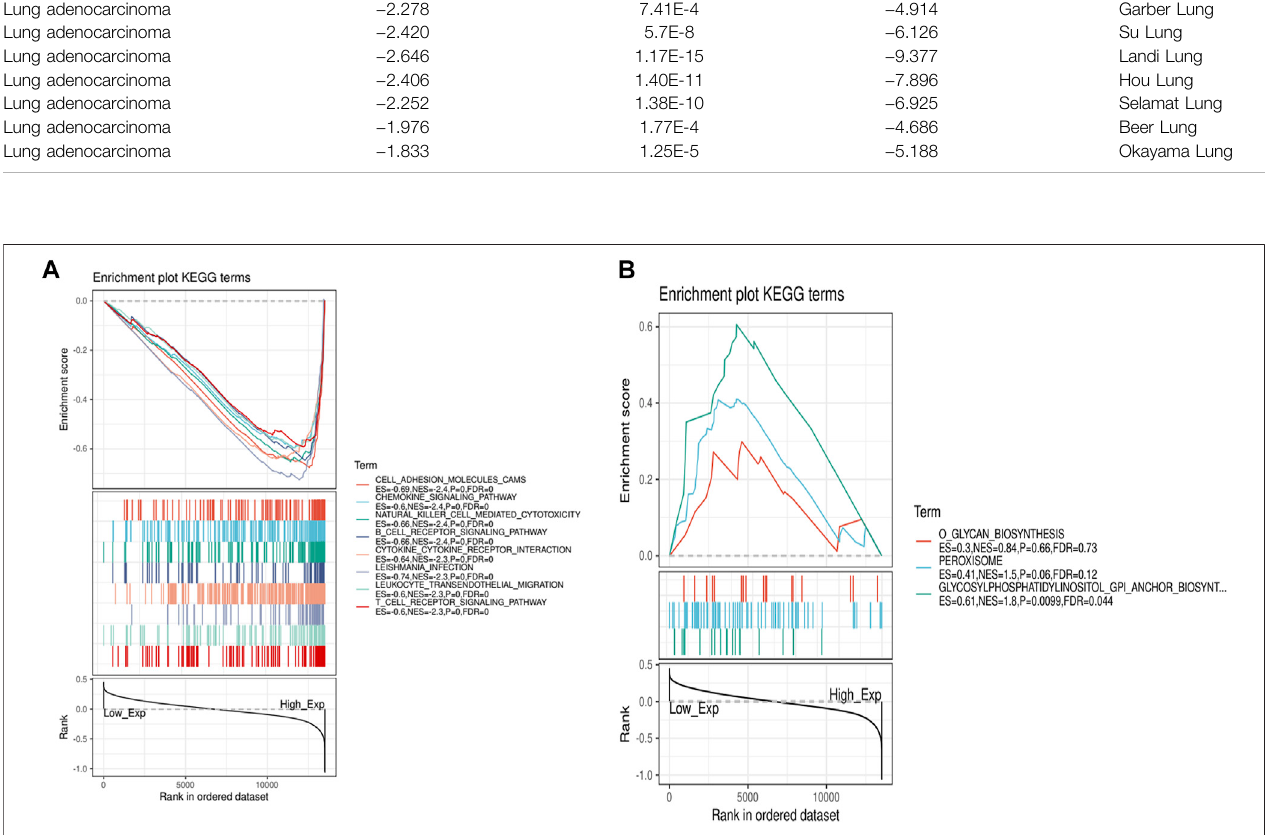
FIGURE 6 | GSEA for samples with high IL7R expression and low expression. (A) The enriched gene sets in HALLMARK collection by the high IL7R expression sample. Each line representing one particular gene set with unique color, p < 0.05 were considered signi fi cant. (B) The enriched gene sets in HALLMARK by samples with low IL7R expression, p <